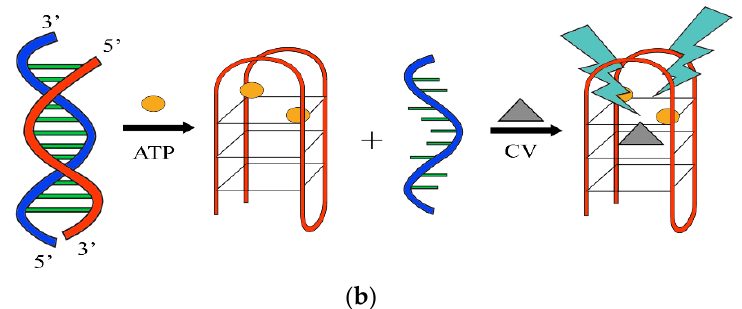
Figure 17. ( a ) Chemical structure of crystal violet. ( b ) Schematic representation of the aptamer-based fluorescent turn-on strategy for ATP detection using G-quadruplex probe crystal violet (CV). ATP promotes duplex dissociation and incudes formation of the aptamer-target G-quadruplex structure, which is detected by CV.